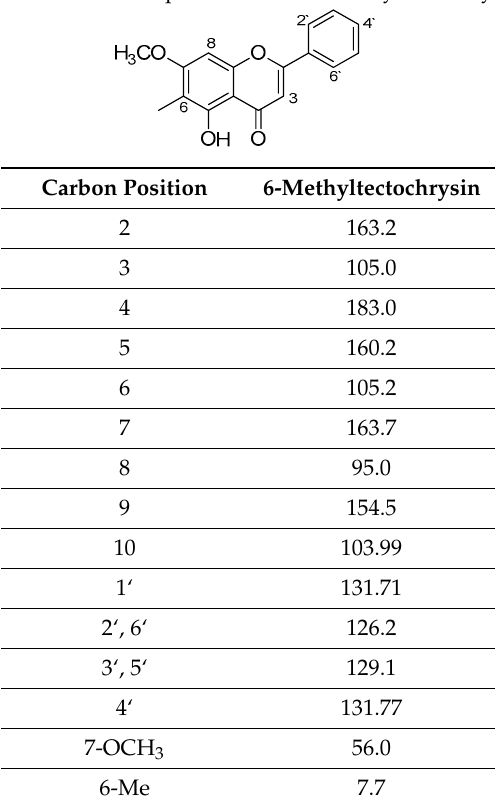
Table 1. 13 C-NMR spectral data of 6-methyltectochrysin.